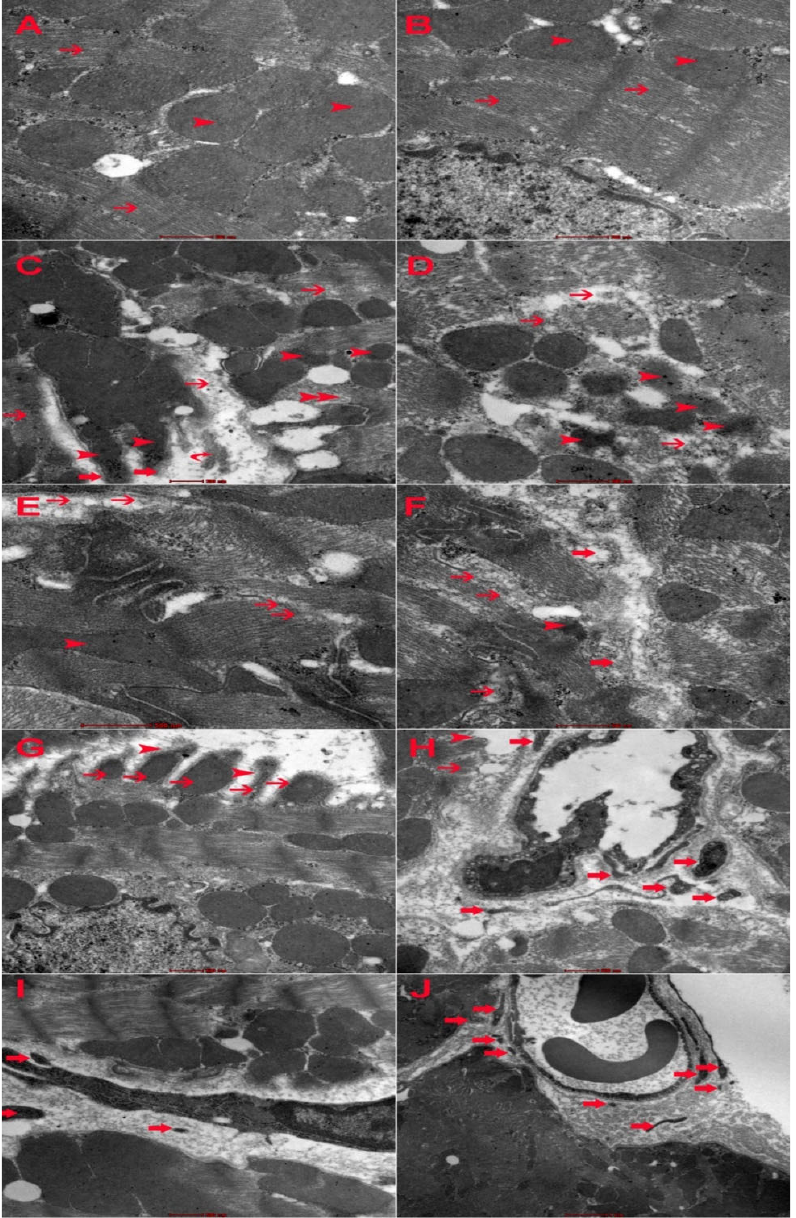
Figure 7. ( A ) Representative ultrathin section of cardiomyocyte from Gal ‐ 3 wild type saline ‐ treated mice showing normal myofilaments (thin arrow) and mitochondria (arrowhead). ( B ) Representative ultrathin section of cardiomyocyte from Gal ‐ 3 KO saline ‐ treated mice showing normal myofilaments (thin arrow) and mitochondria. ( C ) Representative ultrathin section of cardiomyocyte from Gal ‐ 3 wild type DOXO ‐ treated mice showing damaged myofilaments (thin arrow) and damaged mitochondria (arrowhead). ( D ) Representative ultrathin section of cardiomyocyte from Gal ‐ 3 KO DOXO-treated mice show- ing damaged myofilaments (thin arrow) and damaged mitochondria (arrowhead). ( E )